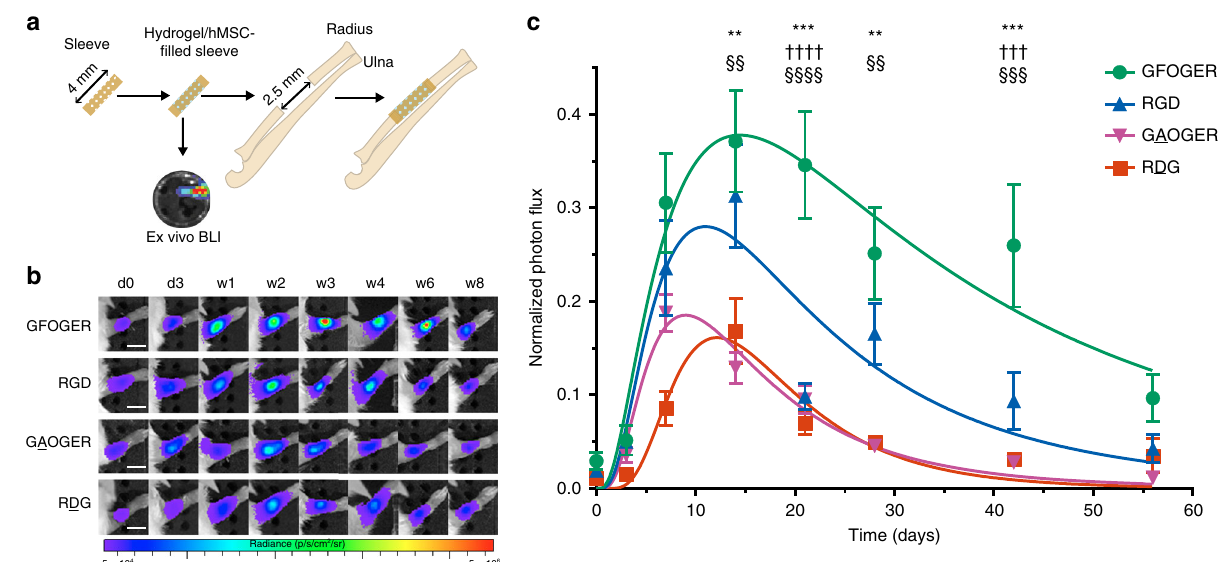
Fig. 3 Adhesive peptide-functionalized hydrogels modulate transplanted hMSC survival and persistence. a Schematic of hydrogel implantation in radial segmental defect. A 4 mm perforated, polyimide sleeve was fi lled with hydrogel/hMSC before surgery and bioluminescence was measured. A 2.5 mm defect was created in the right radius of a mouse and the hydrogel- fi lled sleeve was fi tted over the ends of the defect followed by in vivo bioluminescence imaging over the course of the study. b Representative bioluminescence images over time for each treatment group. Scale bar 5mm. c In vivo bioluminescence signal for hMSC FLuc delivered in hydrogels implanted into radial defects was monitored using IVIS, and photon fl ux at each time point was normalized to initial, pre- implantation fl ux of each implant. Sample size (mice): GFOGER = 13, RGD = 8, GAOGER = 6, RDG = 8, over two independent experiments; mean± SE. Two- way repeated-measures ANOVA (peptide: p < 0.0001, time: p < 0.0001) was used to detect statistical differences followed by Sidak ’ s multiple comparisons test, ** p < 0.001, *** p < 0.0001 GFOGER vs. GAOGER; §§ p < 0.01, §§§ p < 0.001, §§§§§ p < 0.0001 GFOGER vs. RDG; ††† p < 0.008, †††† p < 0.0001 GFOGER vs.